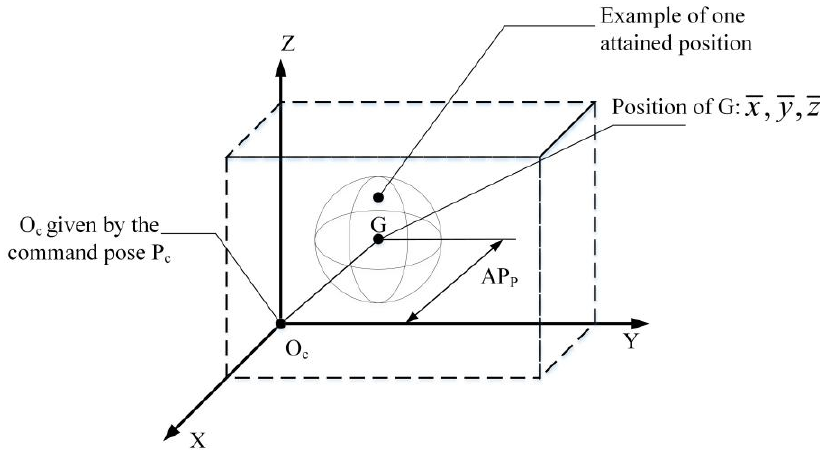
Figure 6. Positioning accuracy.